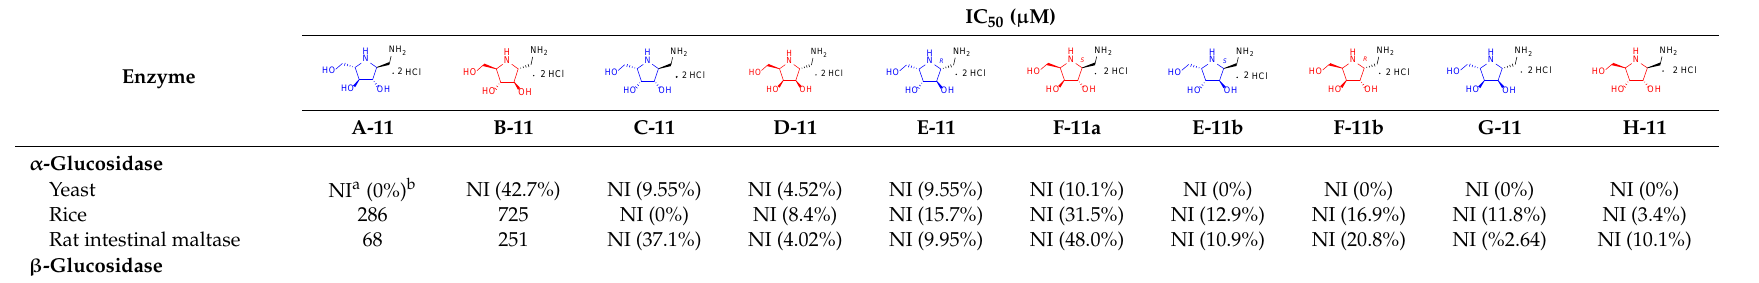
Table 3. Concentrations of 1-amino pyrrolidine analogues giving 50% inhibition of various enzymes.